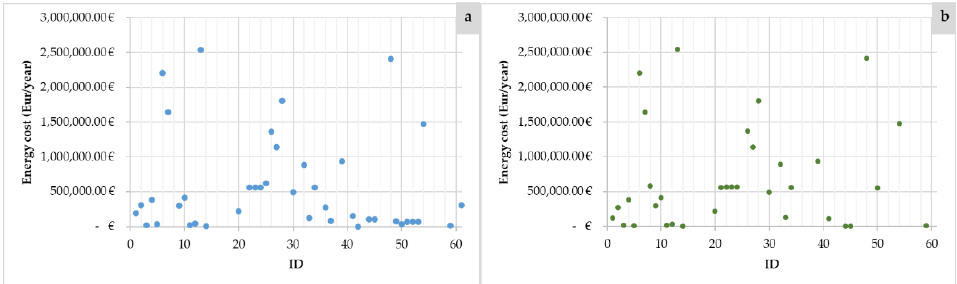
Figure 8. Energy cost related to water usage for OS ( a ) and MS ( b ).